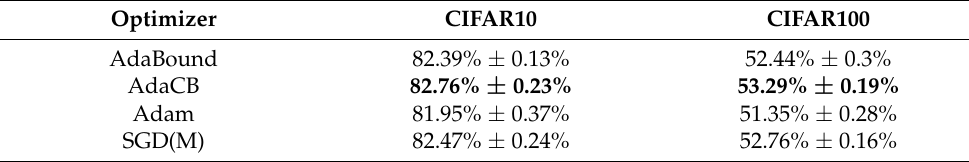
Figure 3. The learning curve of testing accuracy on CIFAR100 under Smallnet. Table 3. The performance of optimizers on cifar10 and cifar100 under smallnet. Optimizer